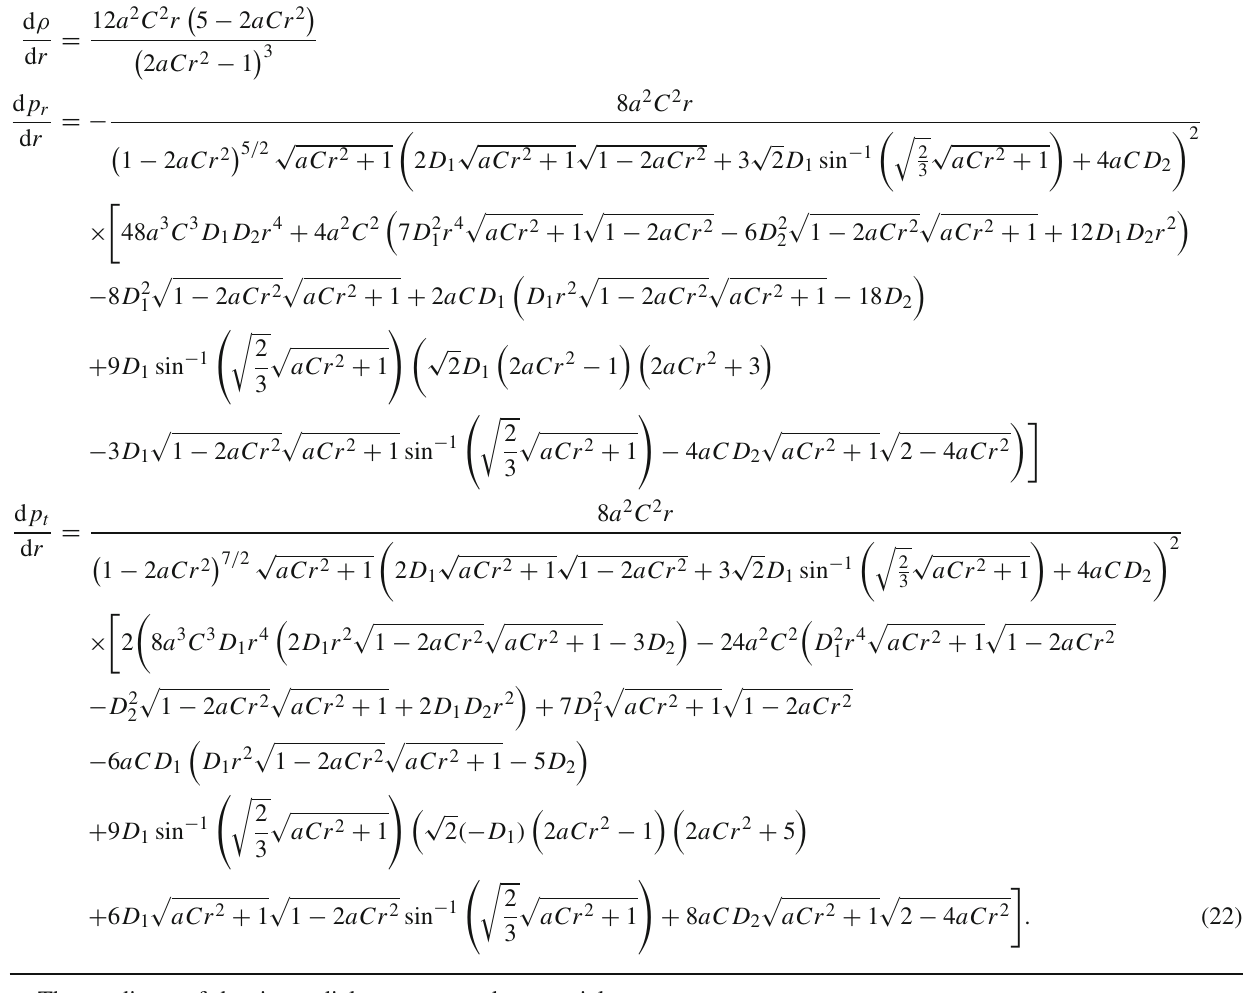
The gradients of density, radial pressure, and tangential pressure are negative inside the stellar body, as shown graph-